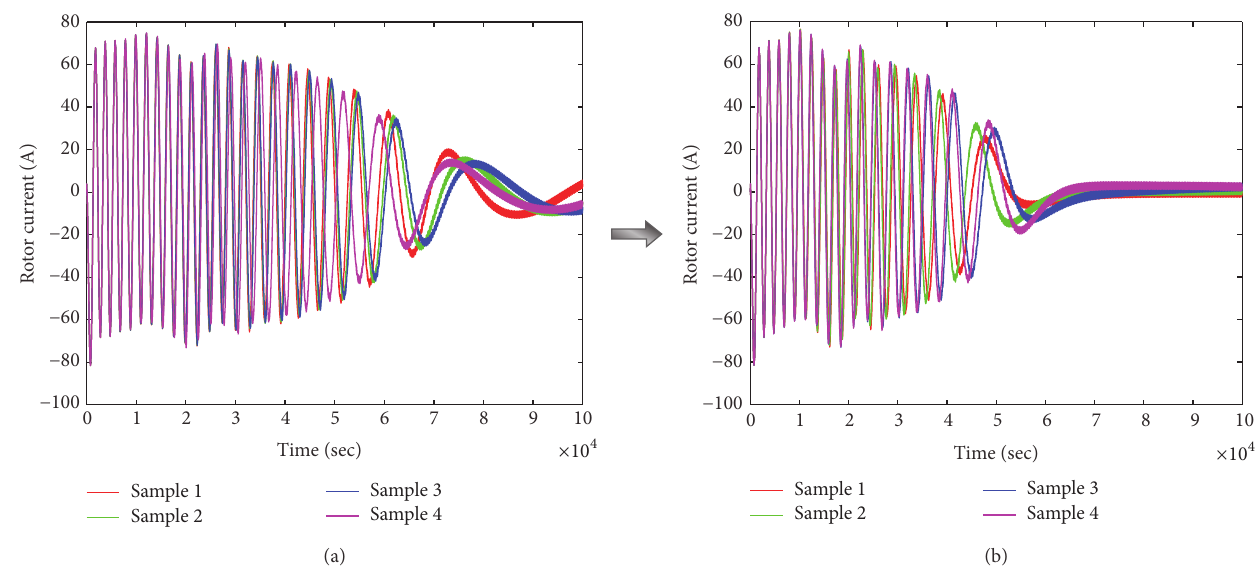
Figure 5: Rotor current comparison of at (a) no-load and (b) rotor lock full load.